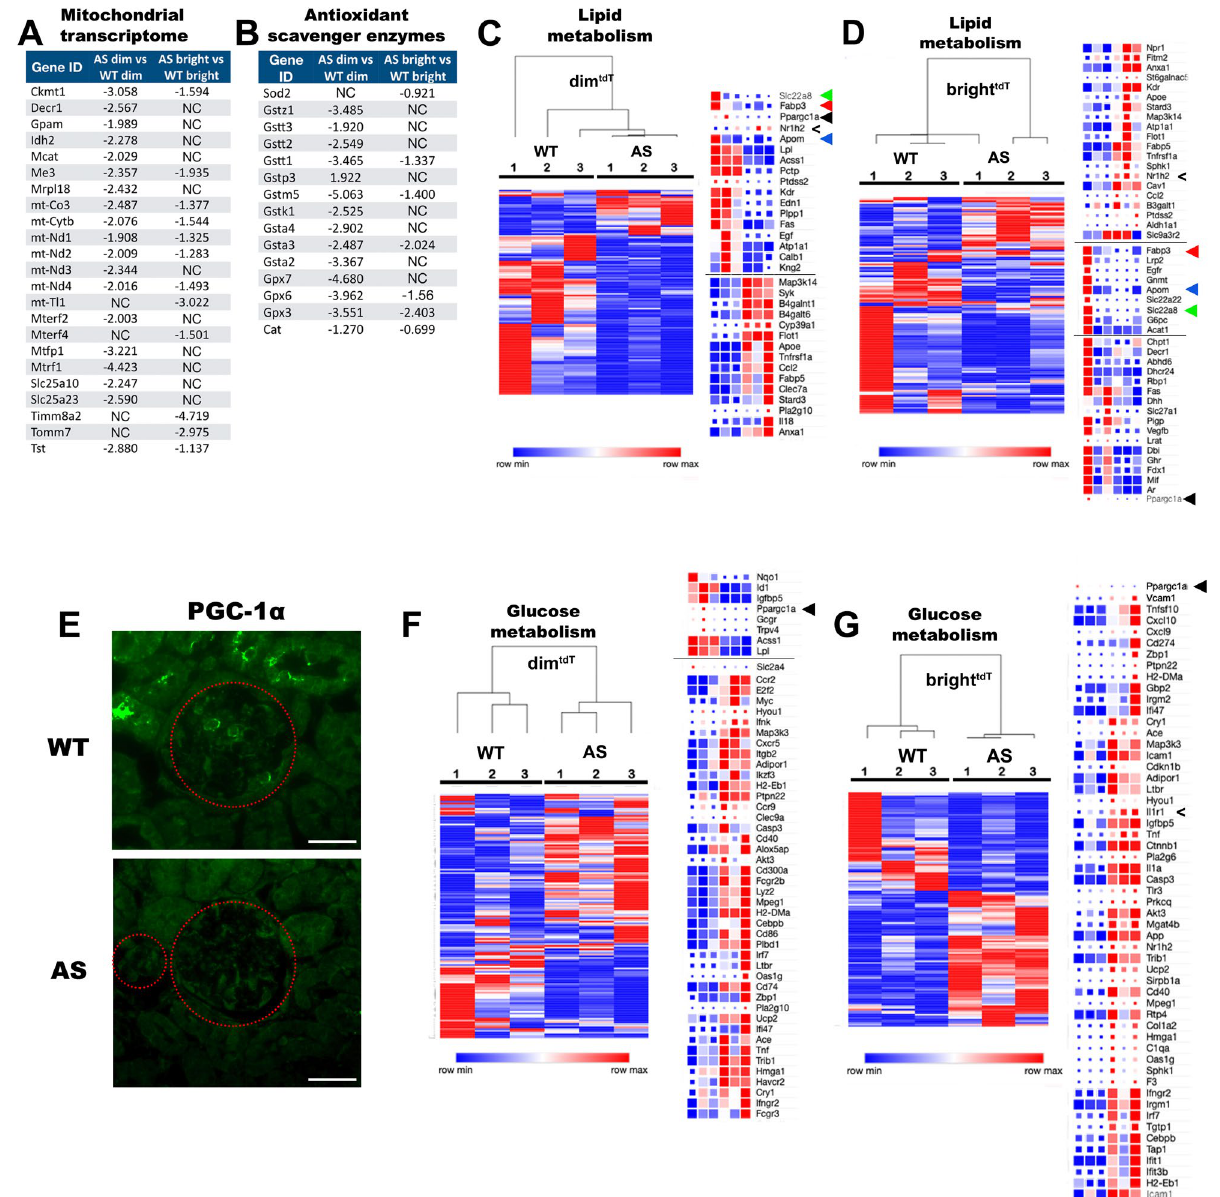
Figure 7. Metabolic hetergeneity of GEC in AS mice. ( A, B) Charts showing the relative fold change expression levels of mitrochondrial genes enriched for oxidative phosphorylation ( A ) and antioxidant enzymatic scavengers ( B ) with consistent downregulation predominantly in the dim tdT GEC in AS mice. ( C, D) Heatmap diagrams with color-coded representation of RPKM values comparing the expression of glucose metabolism associated transcriptome of AS dim tdT ( C ) and AS bright tdT ( D ) and their wild type counterparts respectively. Genes of significance and with high differential expression are listed next to each heatmap. ( E ) Representative immunofluorescence images of mouse kidney sections stained for PGC1α in WT and AS. ( F, G) Heatmap diagrams with color-coded representation of RPKM values comparing the expression of lipid metabolic gene activity of AS dim tdT ( F ) and AS bright tdT ( G ) and their wild type counterparts respectively. Genes of significance and with highly differential expression are shown next to each heatmap. Arrowheads highlight specific genes in the list. The color scale represents relative gene expression levels across each row with red denoting upregulation and blue denoting downregulation. Color intensity indicates stronger regulation. The list of genes included in the lipid and glucose metabolic panels were generated based on the Ingenuity Pathway Analysis of the total RNA-seq data. p value < 0.05 was applied as a cut-off point for all transcriptomic data analysis (biological replicates, n =